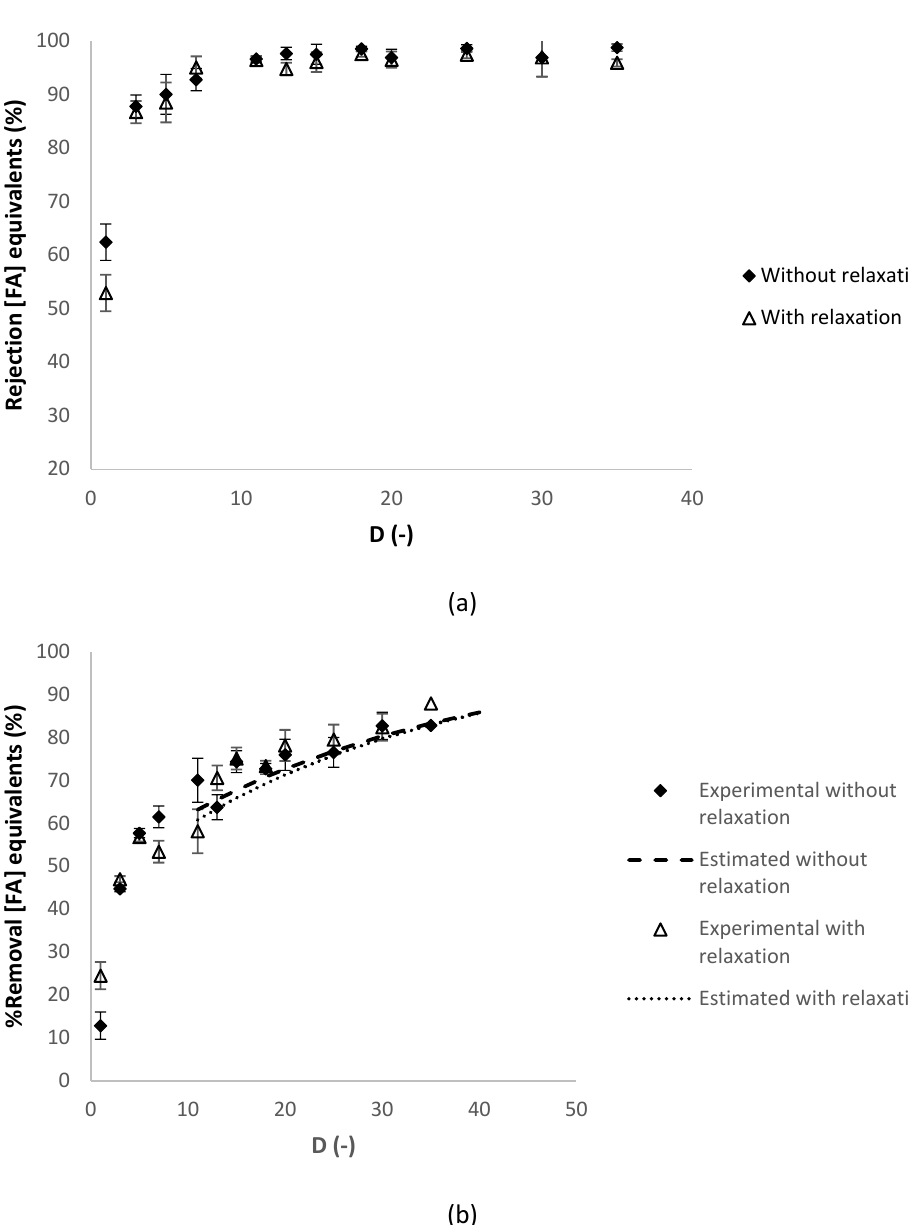
Figure 6. Dia-ultrafiltration with and without relaxation technique of membrane at 40 ◦ C with a (diluted) arabinoxylans fraction as feed, at 40 ◦ C, with an Re feed of 184: ( a ) R FA (%FA.eq), apparent rejection in ferulic acid equivalents and ( b ) percentage of removal of charged contaminants in ferulic acid equivalents (FA.eq) against the D (-) diafiltration volume. Each analysis had duplicate measurements.